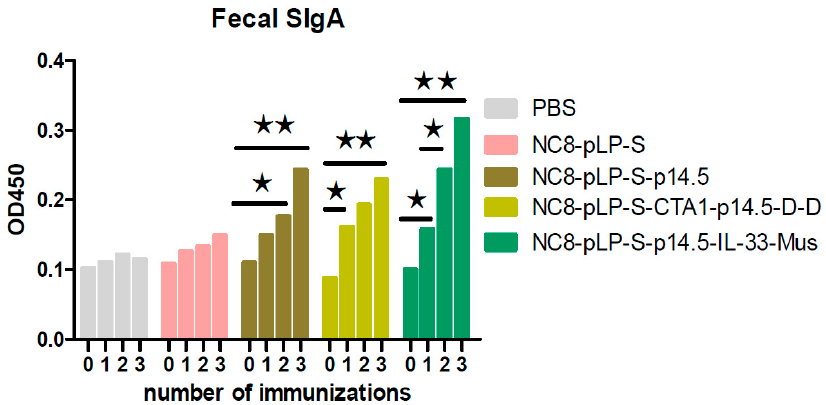
Figure 5. Detection of mouse feces using ELISA assay. Comparison of the increase in fecal IgA con- tent in the five groups of mice after three immunizations. The secretion of SIgA in descending order is the CTA1-DD adjuvant group, IL-33 adjuvant group, single antigen group, empty vector group and the control group. * p < 0.05 and ** p < 0.01 compared with the SIgA before